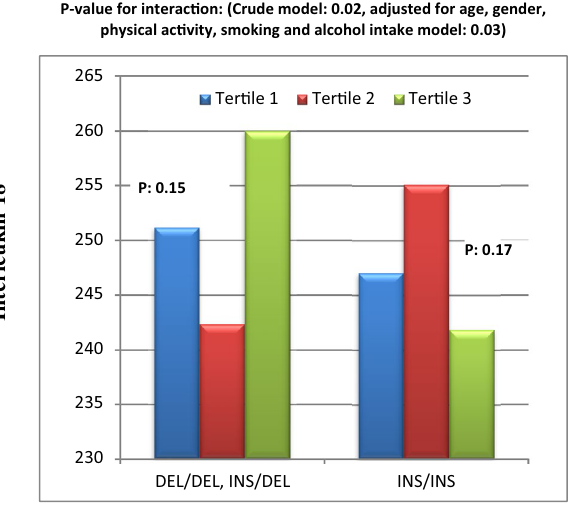
Figure 3. Interaction between Apo B INS/DEL SNP and HEI-2015 on serum interleukin 18